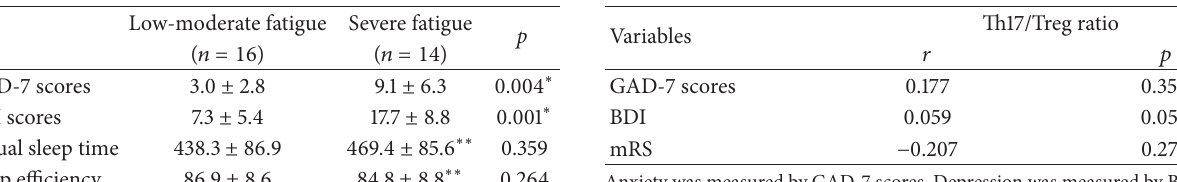
Table 4: Correlation of Th17/Treg ratio with anxiety, depression, and stroke